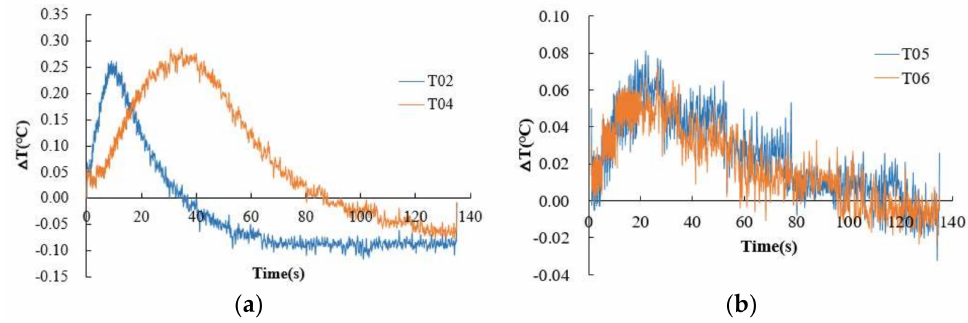
Figure 6. The temperature relative values change curve of the main roadway and branch roadway. ( a ) Main roadway; ( b ) Branch